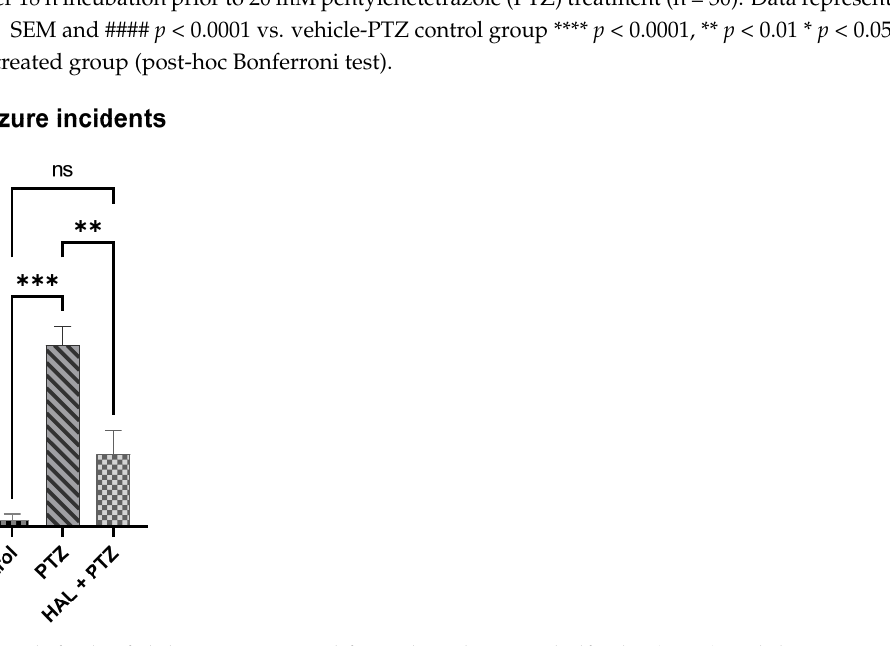
Figure 4. 7-dpf zebrafish larvae pretreated for 18 h with 20 μ M halfordin (HAL) and then 20 mM pentylenetetrazole PTZ displayed a decreased number of seizures over a 20 min period